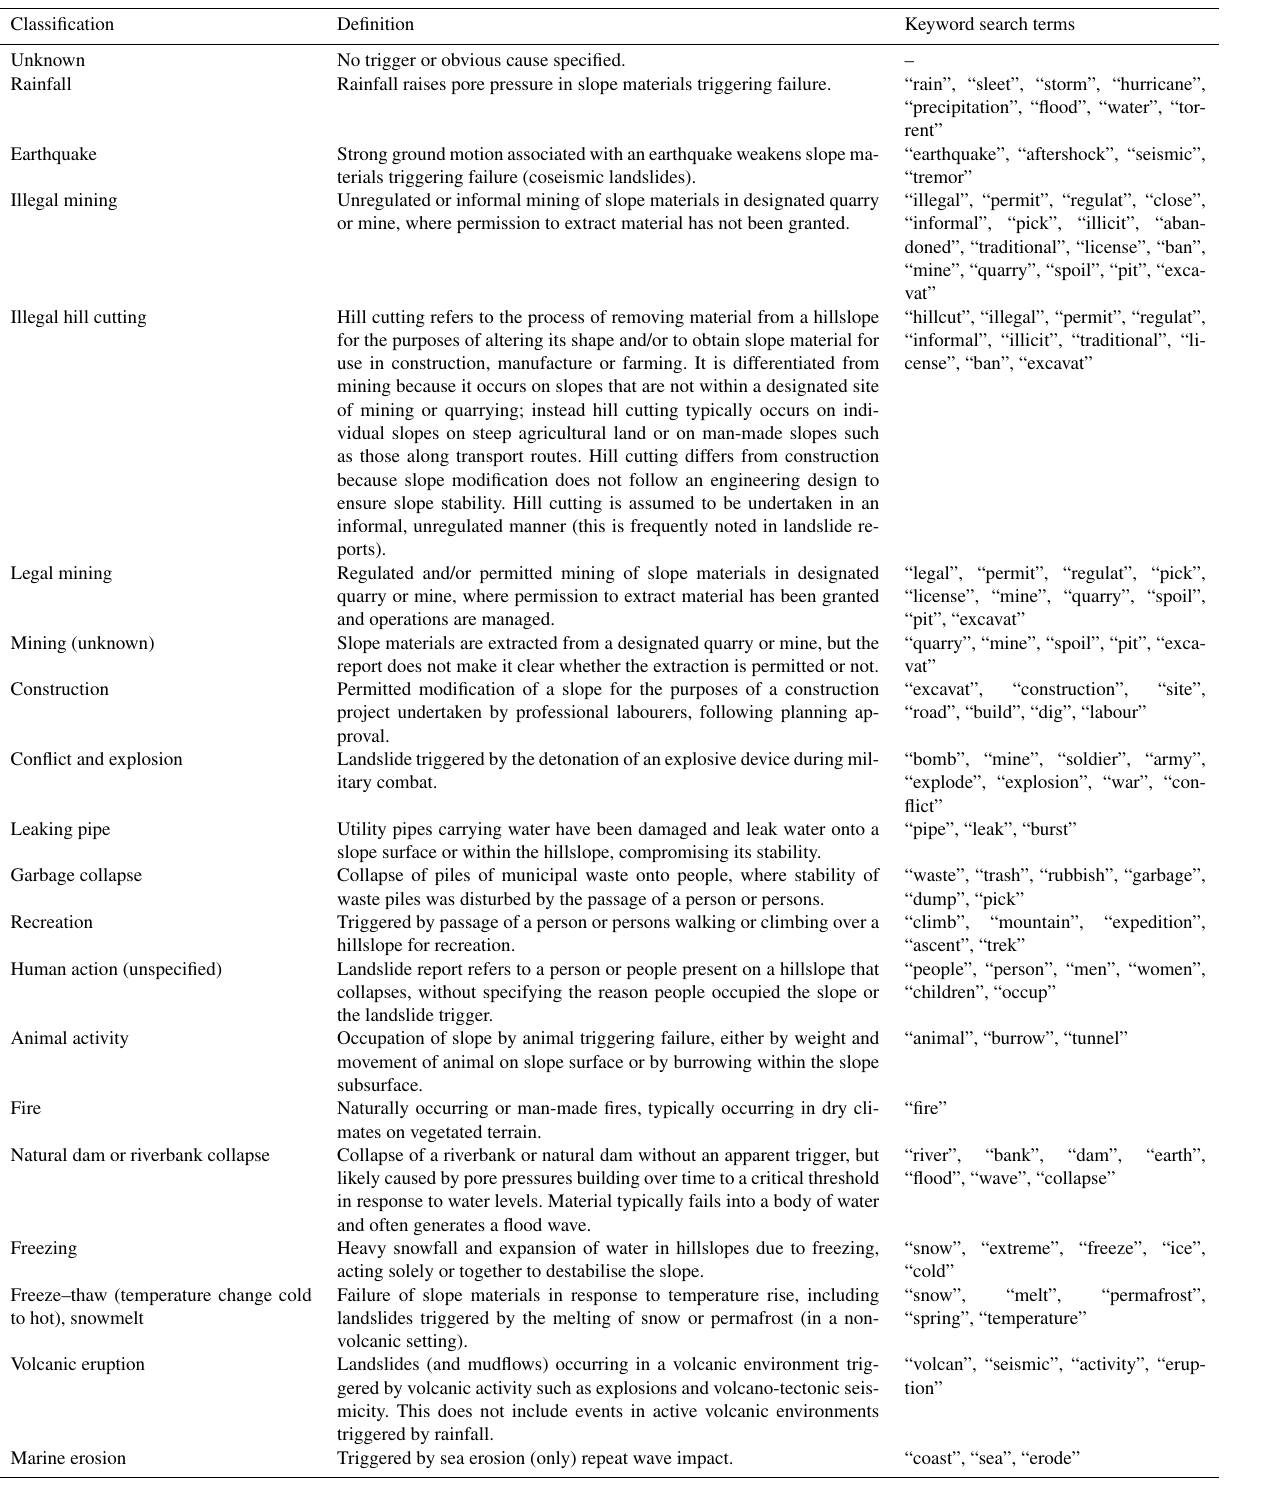
Table 1. Landslide trigger